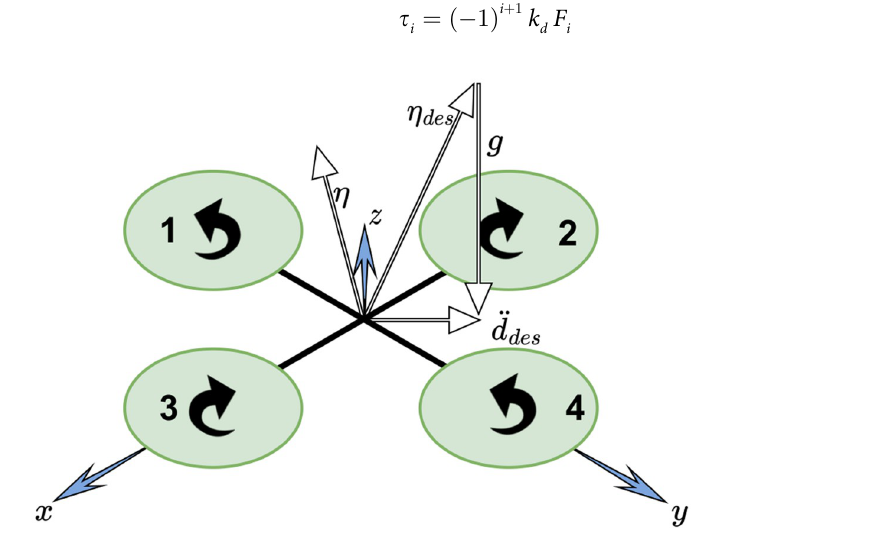
Fig 1. Six degrees of freedom quadrotor